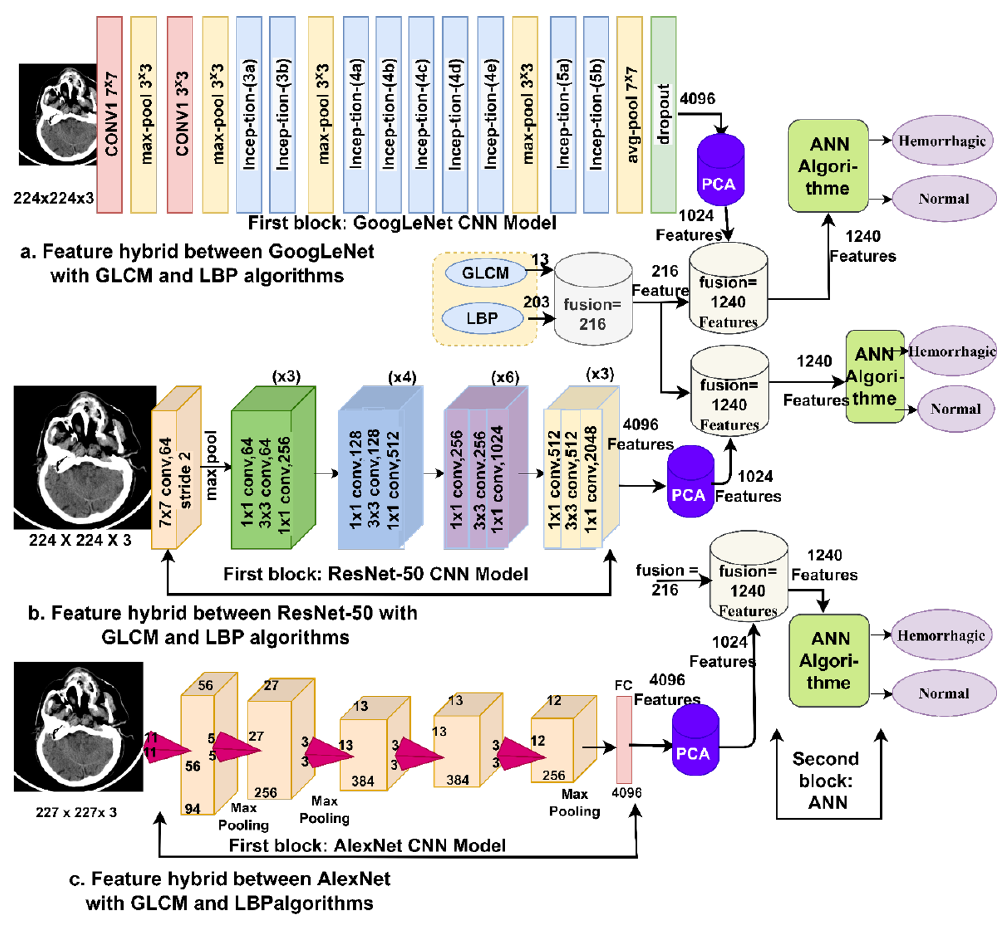
Figure 6. Basic methodology of hybrid feature extraction technique between CNN models and GLCM and LBP algorithms and their classification by an